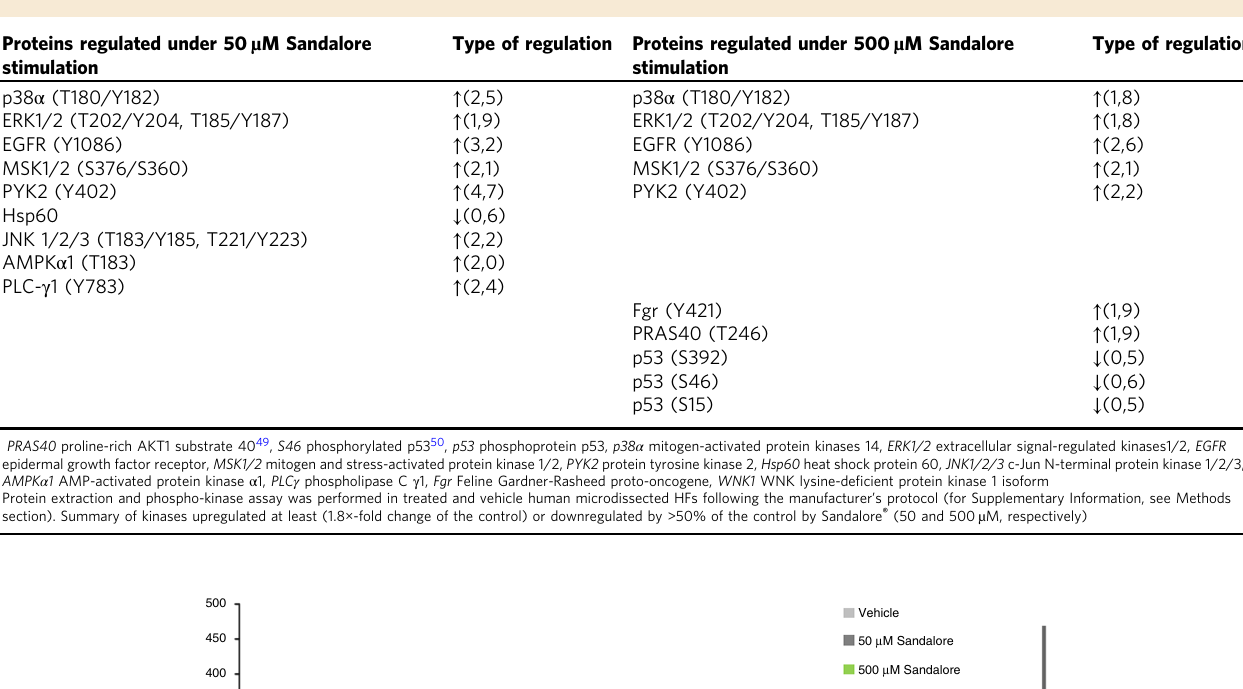
Type of regulation